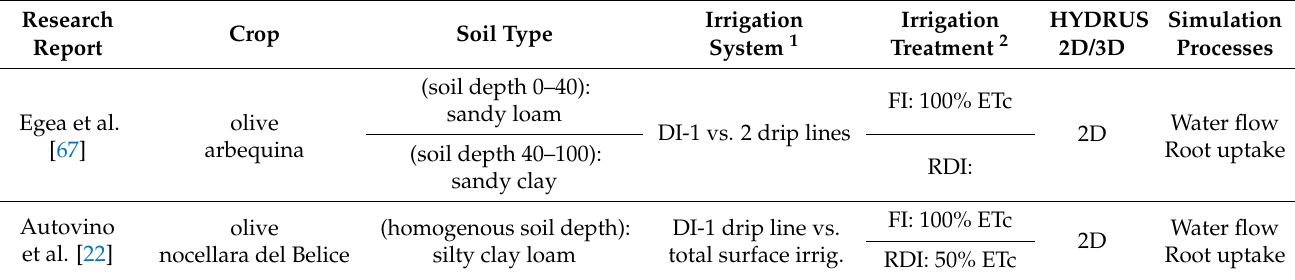
Table 2. Summary of HYDRUS 2D/3D simulations in olive